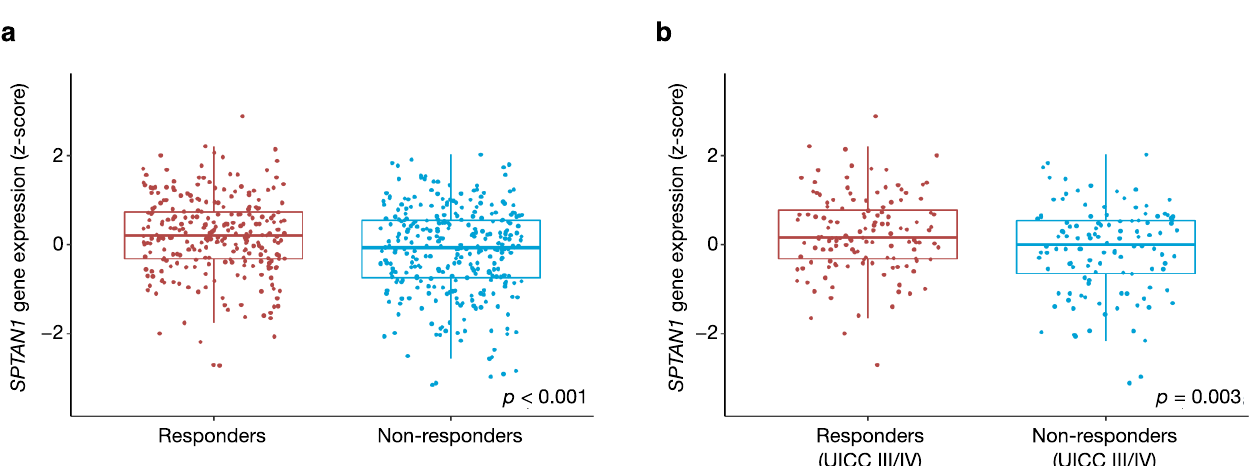
Figure 4. SPTAN1 gene expression predicts response to FOLFOX chemotherapy. Box plots showing the association between SPTAN1 transcript levels and response to FOLFOX chemotherapy ( a ) in the full TCGA cohort, and ( b ) in the subgroup with advanced (UICC stage III/IV) CRC. A previously established molecular classifier was applied to the TCGA expression data, in order to predict individual patients’ responses to FOLFOX chemotherapy. Mean SPTAN1 transcript levels in predicted responders and non-responders were compared using the t -test function in the standard R environment. Results with a p -value < 0.05 were considered statistically significant.